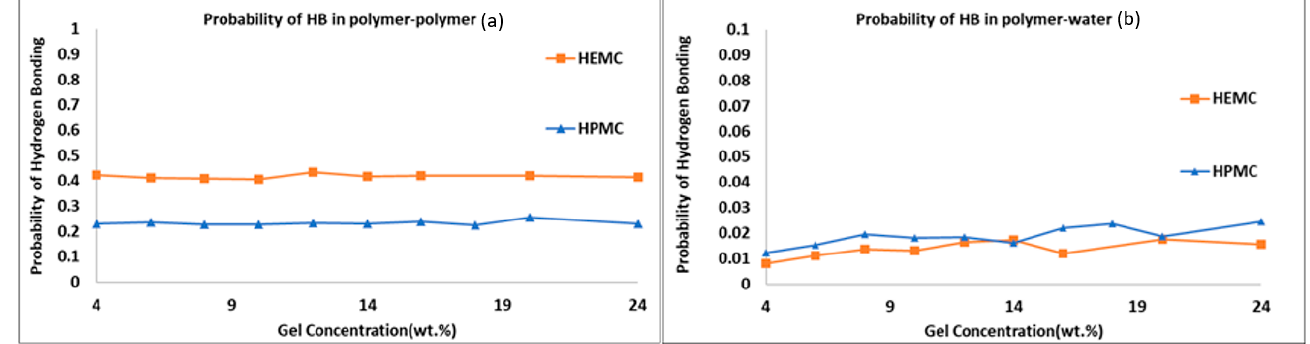
Figure 16. Probability of hydrogen bonding: ( a ) polymer-to-polymer, and ( b ) polymer-to-water.